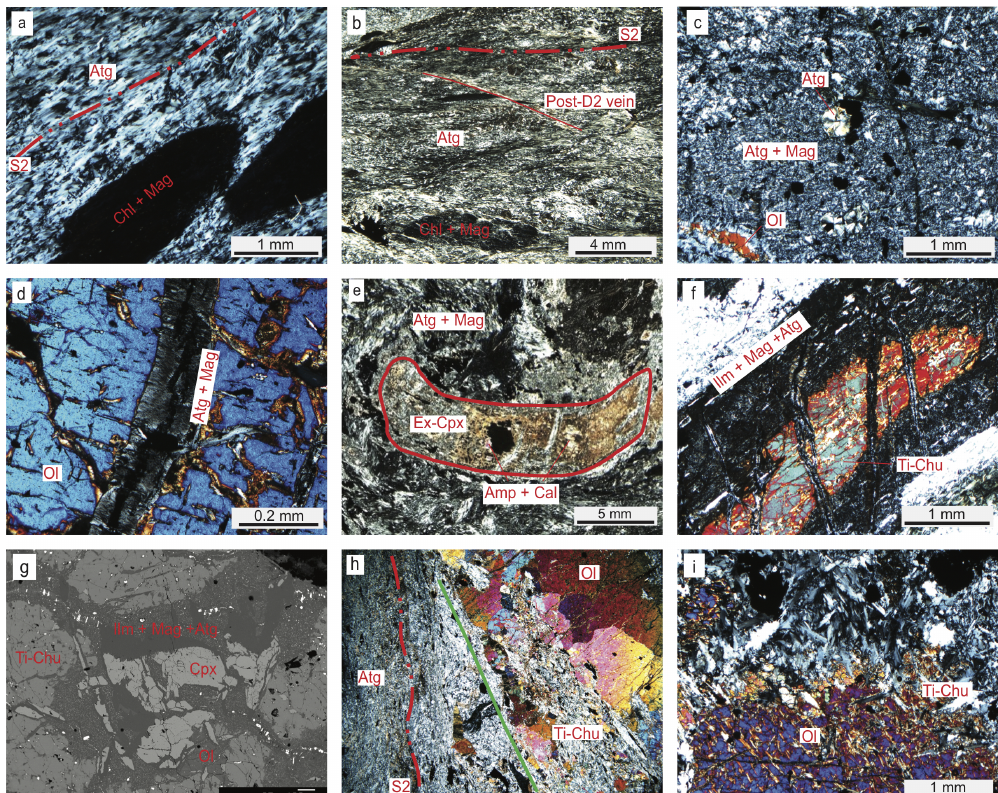
Figure 6. ( a ) Chl + Mag aggregates wrapped by S2 foliation in mylonitic serpentine marked by SPO of Atg. Crossed polars; ( b ) Panoramic view of mylonitic serpentinite with well-developed s-c fabric. Straight post-D2 veins are filled with Atg-Mag-Tlc. ( c ) Non-foliated matrix made of Atg + Mag, radial Atg superimposed on ex-Mag in a Ol-Cpx-Ti-Chu layer section. Crossed polars; ( d ) Ol porphyroclast fractured by post-D2 Atg + Mag veins. Crossed polars; ( e ) Ex-Cpx microsite replaced by Amp+Cal and surrounded by a non-foliated matrix of Atg + Mag in a Ol-Cpx-Ti-Chu layer. Crossed polars; ( f ) Ti-Chu relic rimmed by Atg + Ilm + Mag aggregate in a Ol-Cpx-Ti-Chu layer. Crossed polars; ( g ) BSE image of a Ol-Cpx-Ti-Chu layer showing Ti-Chu, Cpx and Ol aggregate with original polygonal texture. Ti-Chu is rimmed by Atg + Ilm + Mag intergrowth; ( h ) Pre-D2 Ol and Ti-Chu porphyroclasts with Atg SPO marking Pre-S2 foliation (green solid line) at low angle with S2 foliation. Crossed polars. Long side of the microphotograph = 18 mm; ( i ) Ol porphyroclast rimmed by Ti-Chu in a serpentinite with Ol layer. Crossed